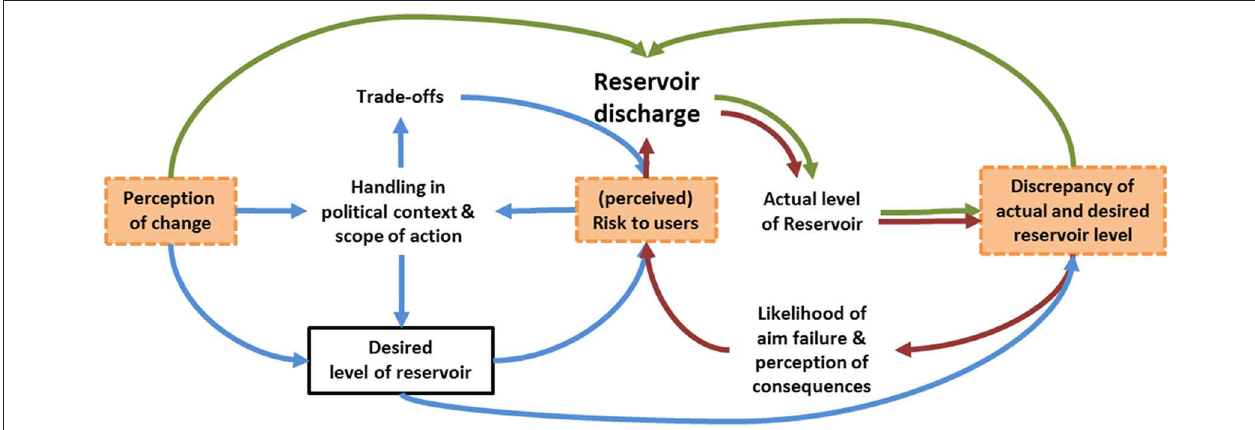
FIGURE 3 | Sensitive System Variables. Overlay of key loops from the different perspectives (green: operational management; red: risk management; blue: strategic/political perspective). Highlighted in orange are the sensitive system variables impacting at least two causal loops.